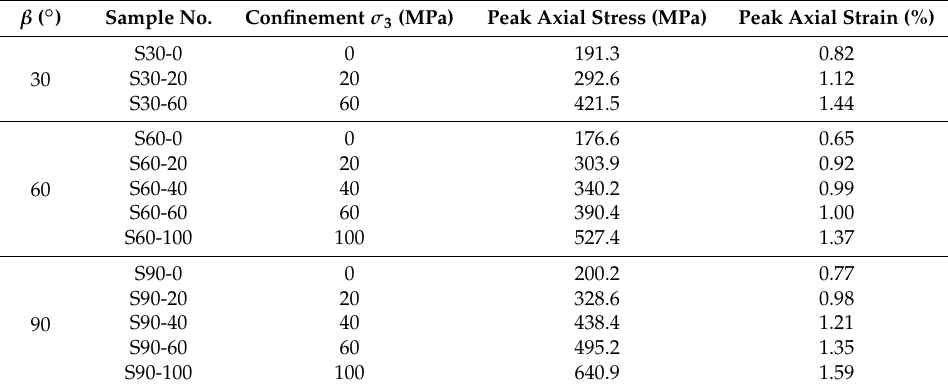
Table 2. Mechanical properties of the shale samples.